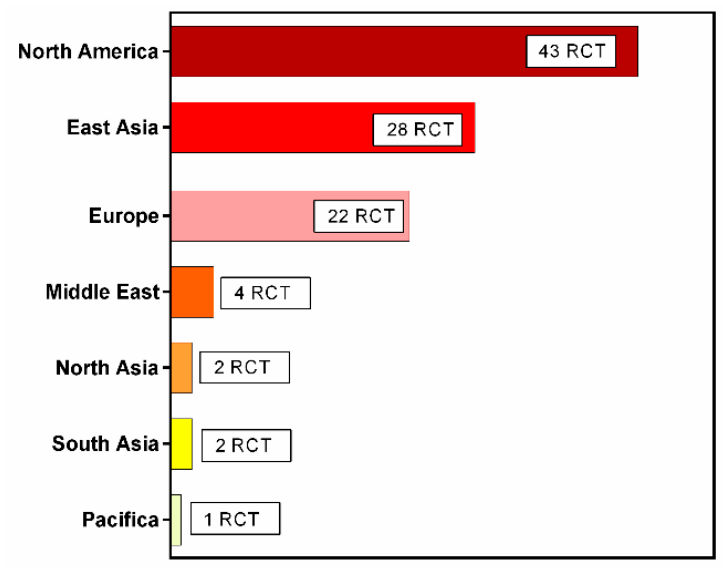
Figure 1. Worldwide distribution of FMT research across regions.